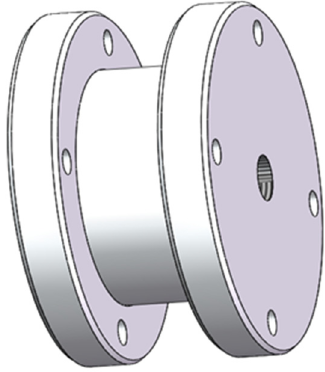
Figure 7. Three-dimensional diagram of the isothermal container.